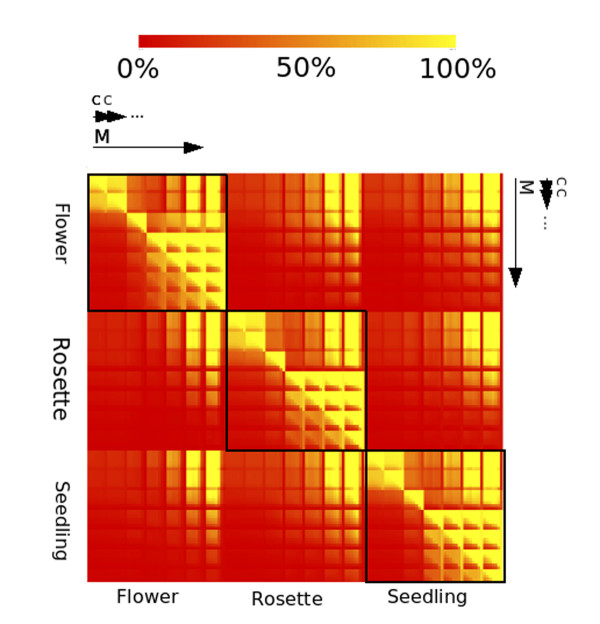
Pairwise comparisons of overlap of sRNA locales generated at all parameter scan values for all sets of Arabidopsis tissues. Within each of the nine visible sub-squares all M values (5, 10, 20, 30, 50, 75, and 100) occur once and all C values occur once for each M repeating a total of seven times within each sub-square. The extent of one scale of M is indicated by one large arrow, the extent of one scale of C is indicated by one small arrow. For each comparison the proportion of overlapping locales is calculated as the number of locales in the locales set represented on the x axis that overlap with the locales in the set represented on the y axis.